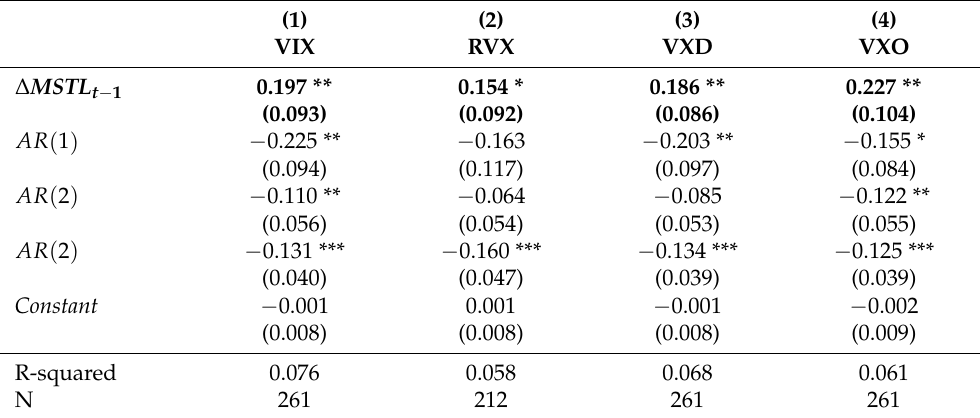
Table 2. Forecasting stock market implied volatility with financial reports tone disagreement: In- sample analysis.